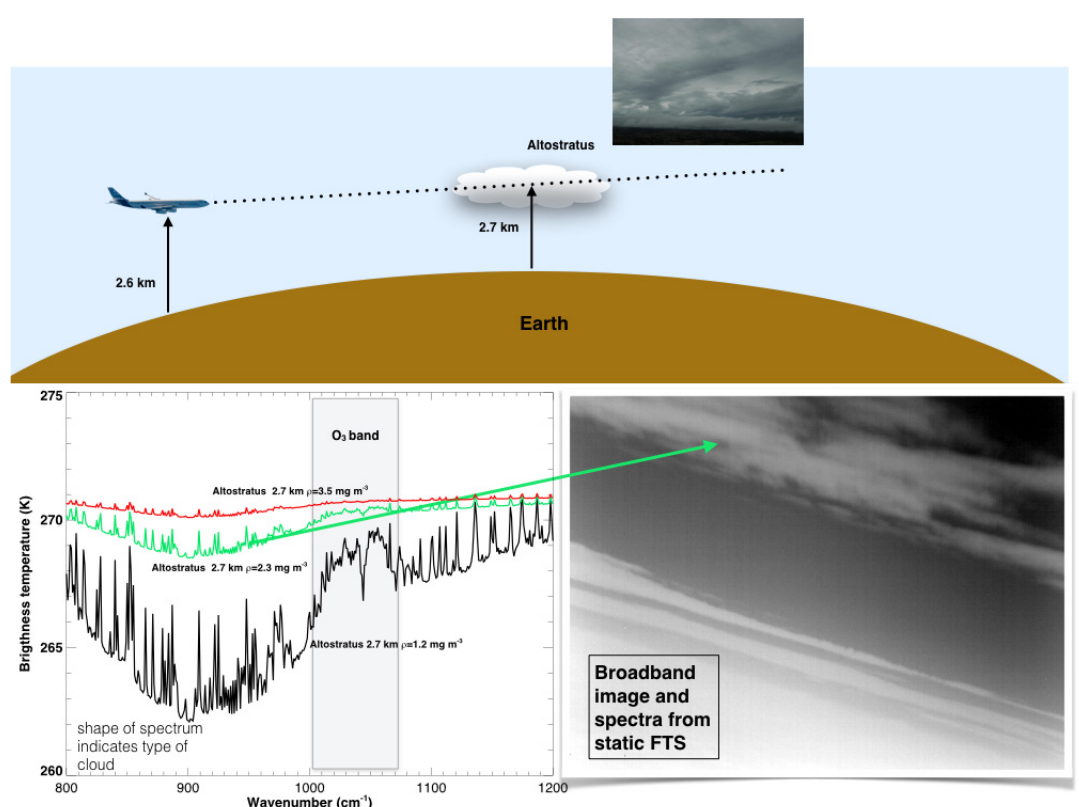
Figure 15. Broadband temperature image acquired by the instrument when the aircraft altitude was 5000 ft and the instrument was viewing upwards and ahead of the aircraft.